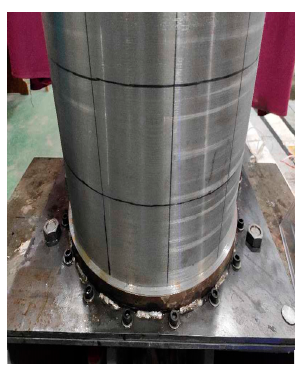
Figure 16. Fixed support.